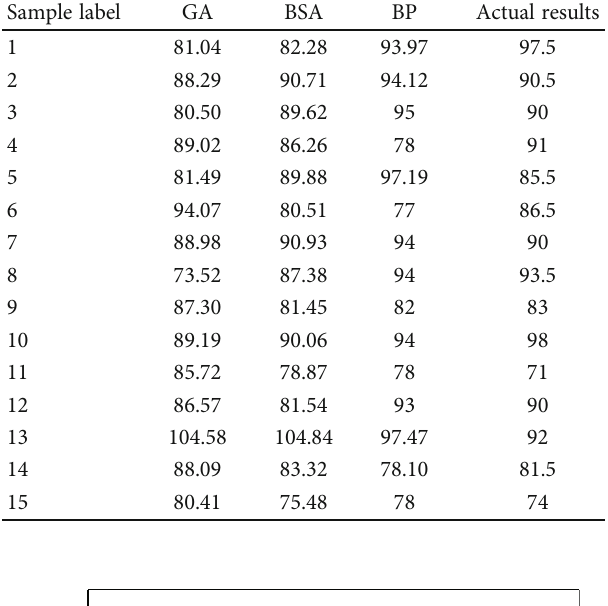
Table 2: Comparison of models.